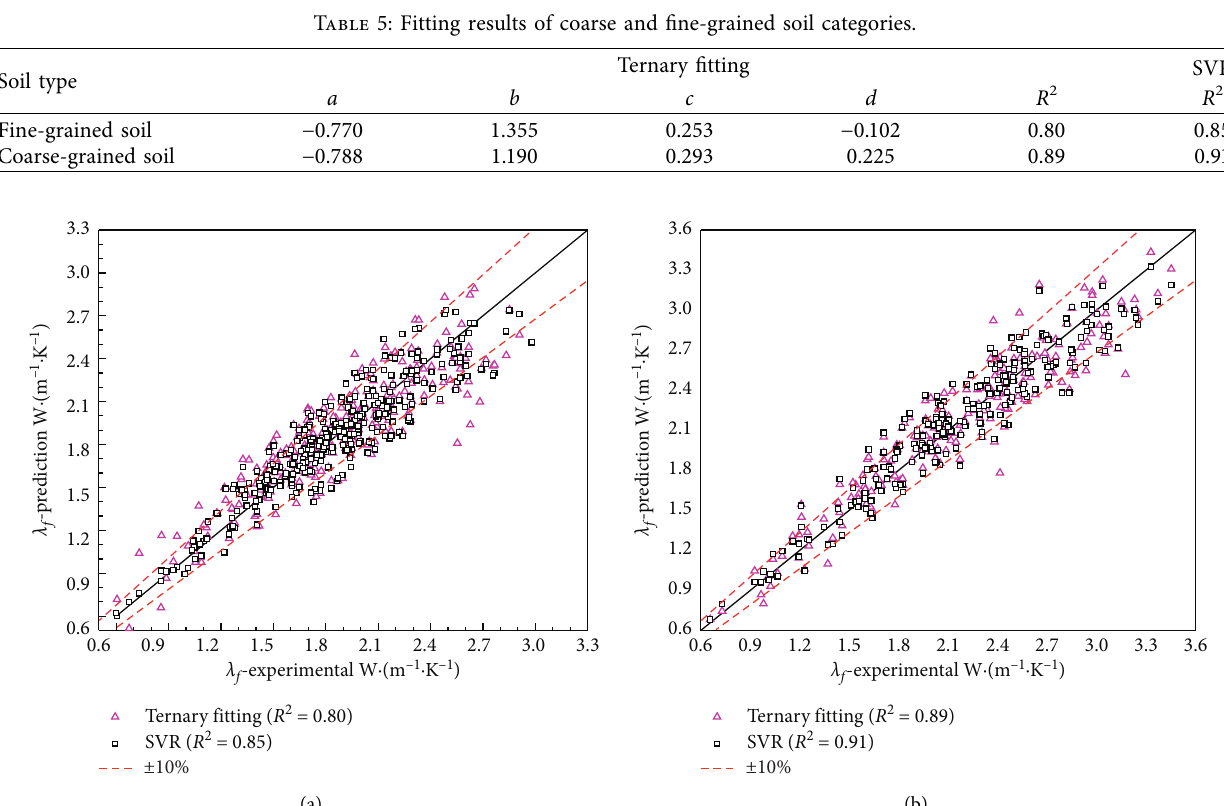
Figure 9: Comparison of predictive results of ternary fitting and SVR models for (a) fine-grained sand and (b) coarse-grained